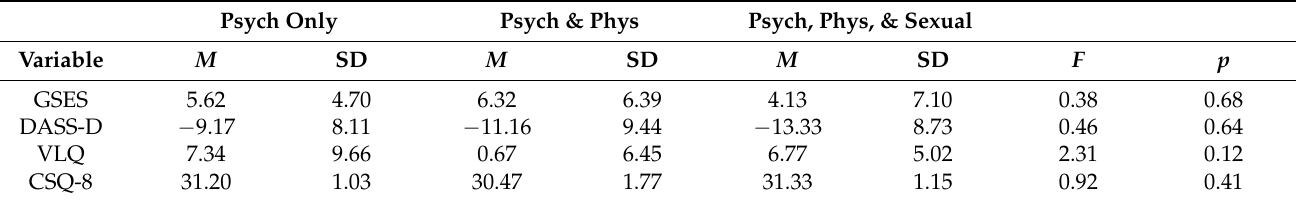
Table 5. Means, Standard Deviations, and One-Way Analyses of Variance for the Effects of IPV Type on Psychosocial Health Outcomes and Satisfaction with Treatment. Psych Only Psych & Phys Psych, Phys, &